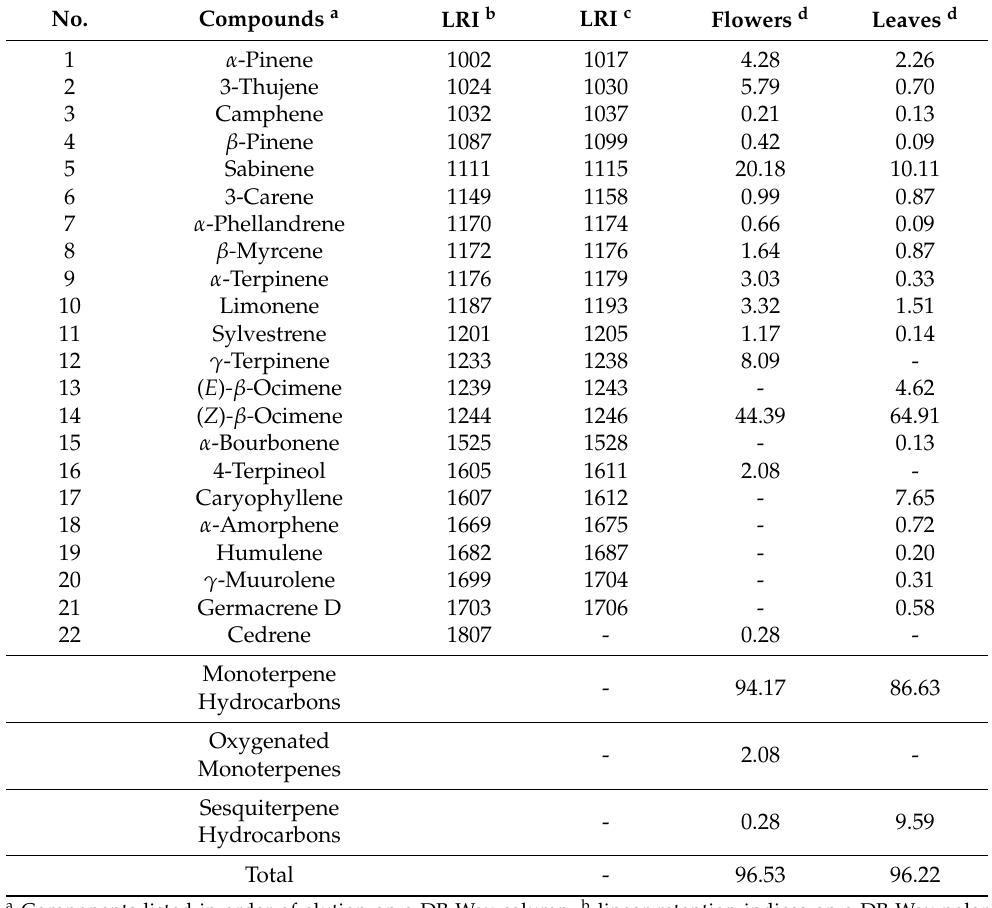
Table 1. Essential oil composition (%) of the flowers and leaves of Prangos ferulacea . No. Compounds a LRI